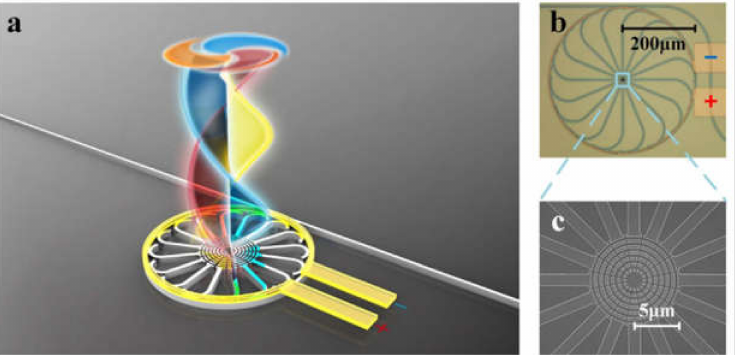
Figure 7. The integrated photonic emitter: ( a ) The graphical illustration [145]; ( b ) the micro- graph [145]; and ( c ) the SEM image of the manufactured device